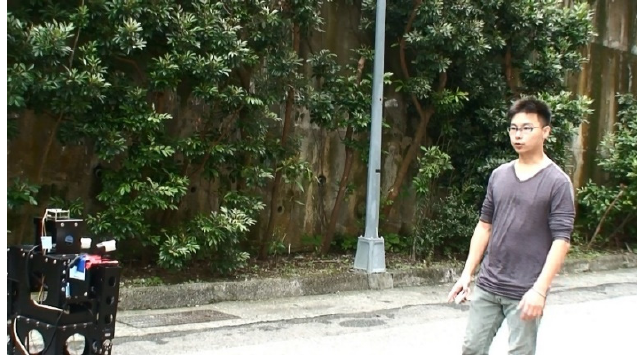
Figure 23. The robot encountered a person appearing in front of it.